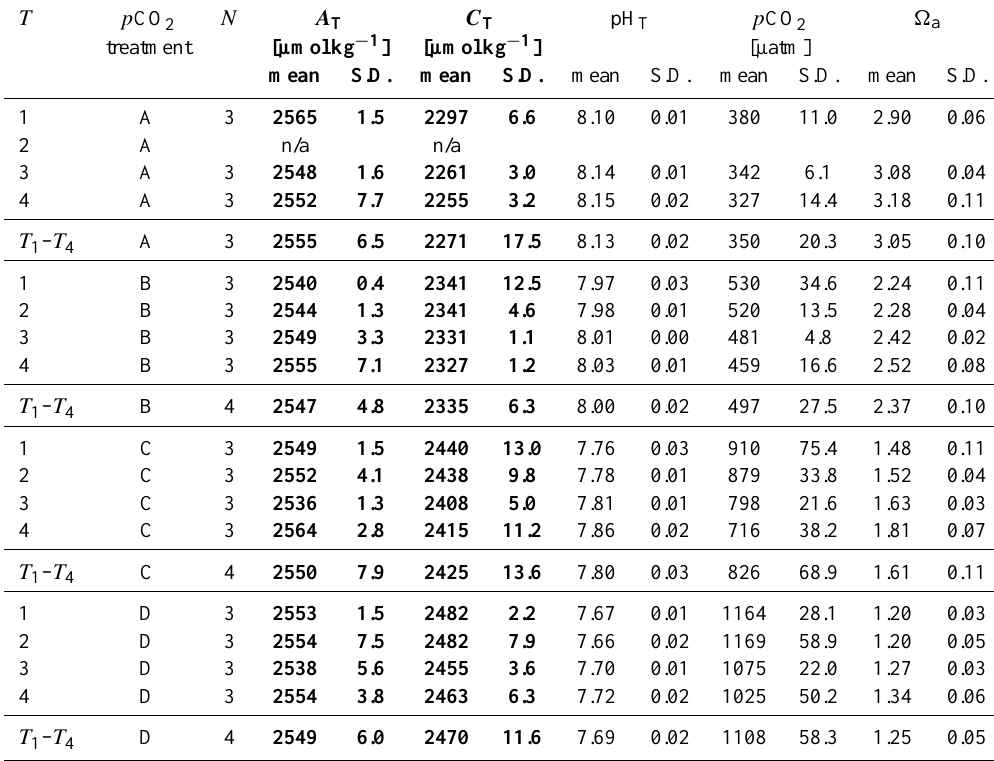
Table 2. Parameters of the carbonate chemistry at the beginning of the incubations. Total alkalinity ( A T ) and dissolved inorganic carbon ( C T ) were measured, while pH on total scale (pH T ) , partial pressure of CO 2 ( p CO 2 ) and the aragonite saturation state ( (cid:127) a ) were calculated. T is the period at which the incubations were performed (at approximately monthly intervals). T 1–4 displays the pooled data for T 1 to T 4